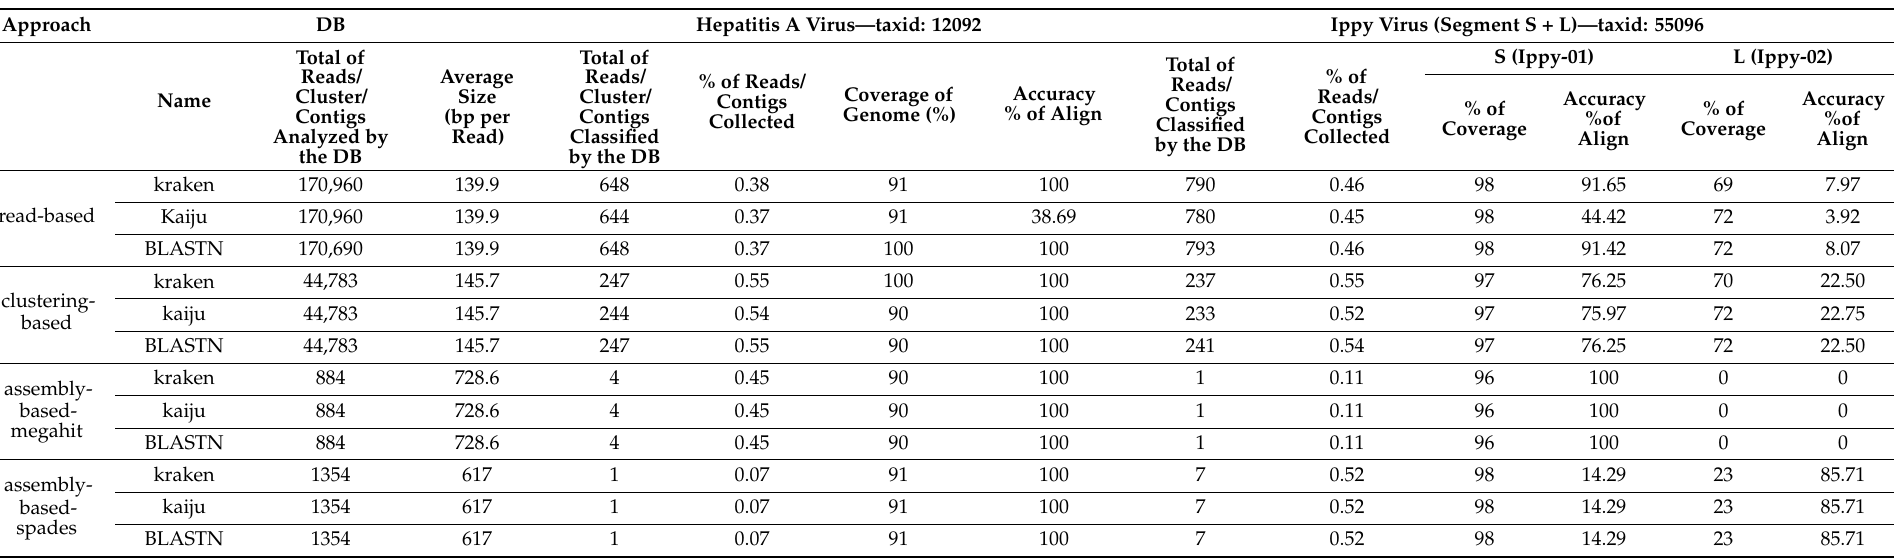
Table 5. PIMGAVir statistics. The table shows the statistical values associated to the taxonomic classification of